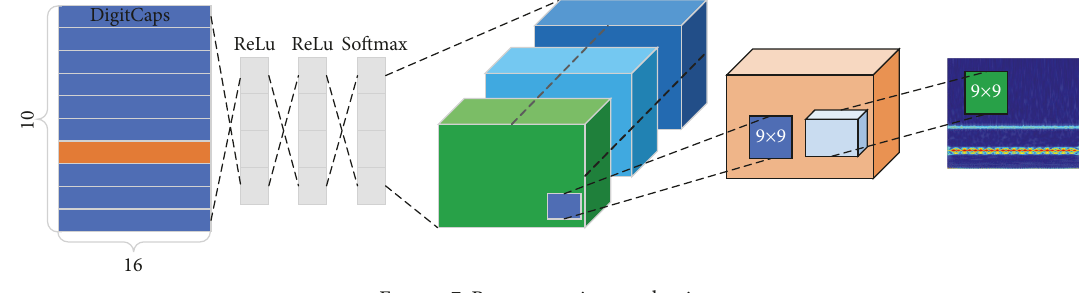
Figure 7: Reconstruction